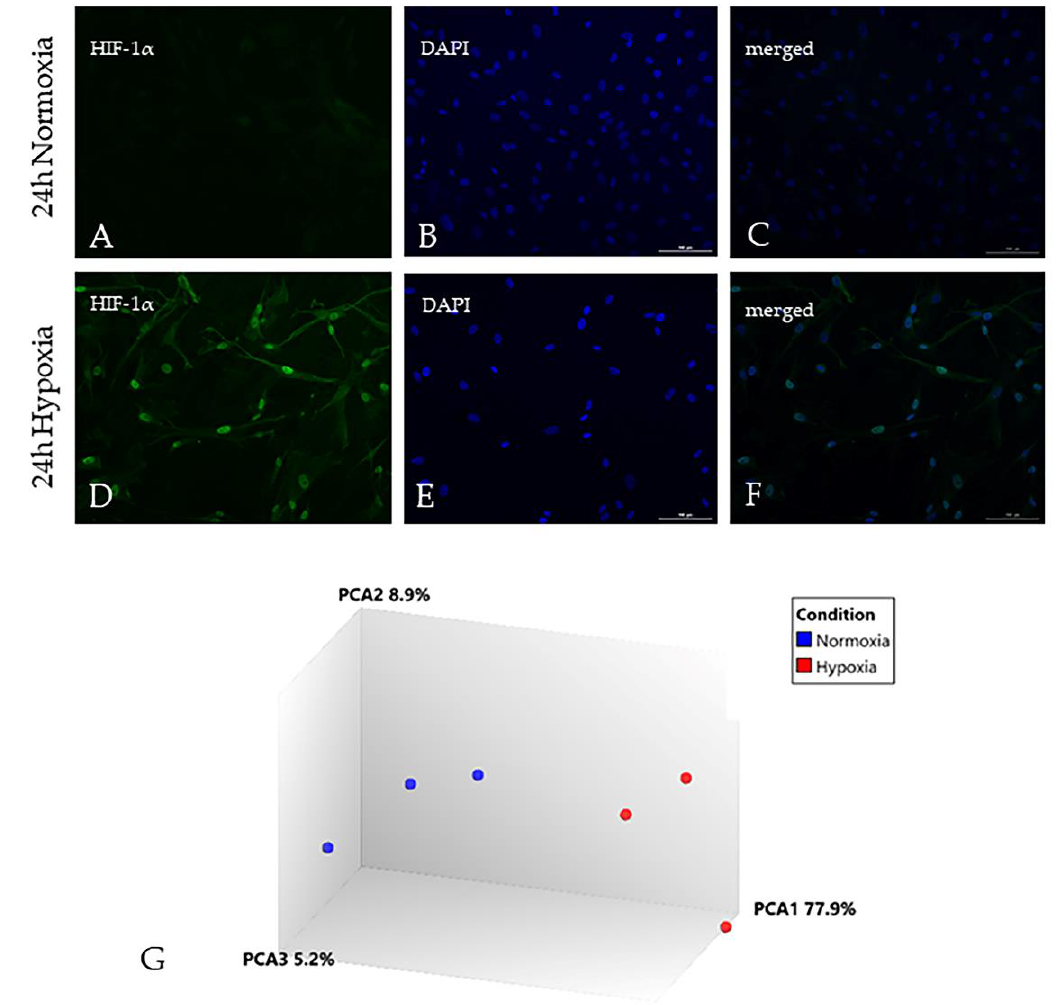
Figure 1. Hypoxia induced changes in the astrocyte gene expression profile. ( A – C ) Under normoxic conditions, low levels of hypoxia inducible factor-1 α (HIF-1 α ) are present in the cytoplasm of astrocytes; ( D – F ) In response to 24 h hypoxia, HIF-1 α translocates to the nucleus of astrocytes; ( G ) Principal component analysis (PCA) of the transcriptomic profile of human astrocytes in response to hypoxia demonstrates clear separation between normoxia (blue) and hypoxia (red) gene expression profiles. Scale bar represents 100 µm ( A – F ). Table 1. Expression of hypoxia-induced transcripts